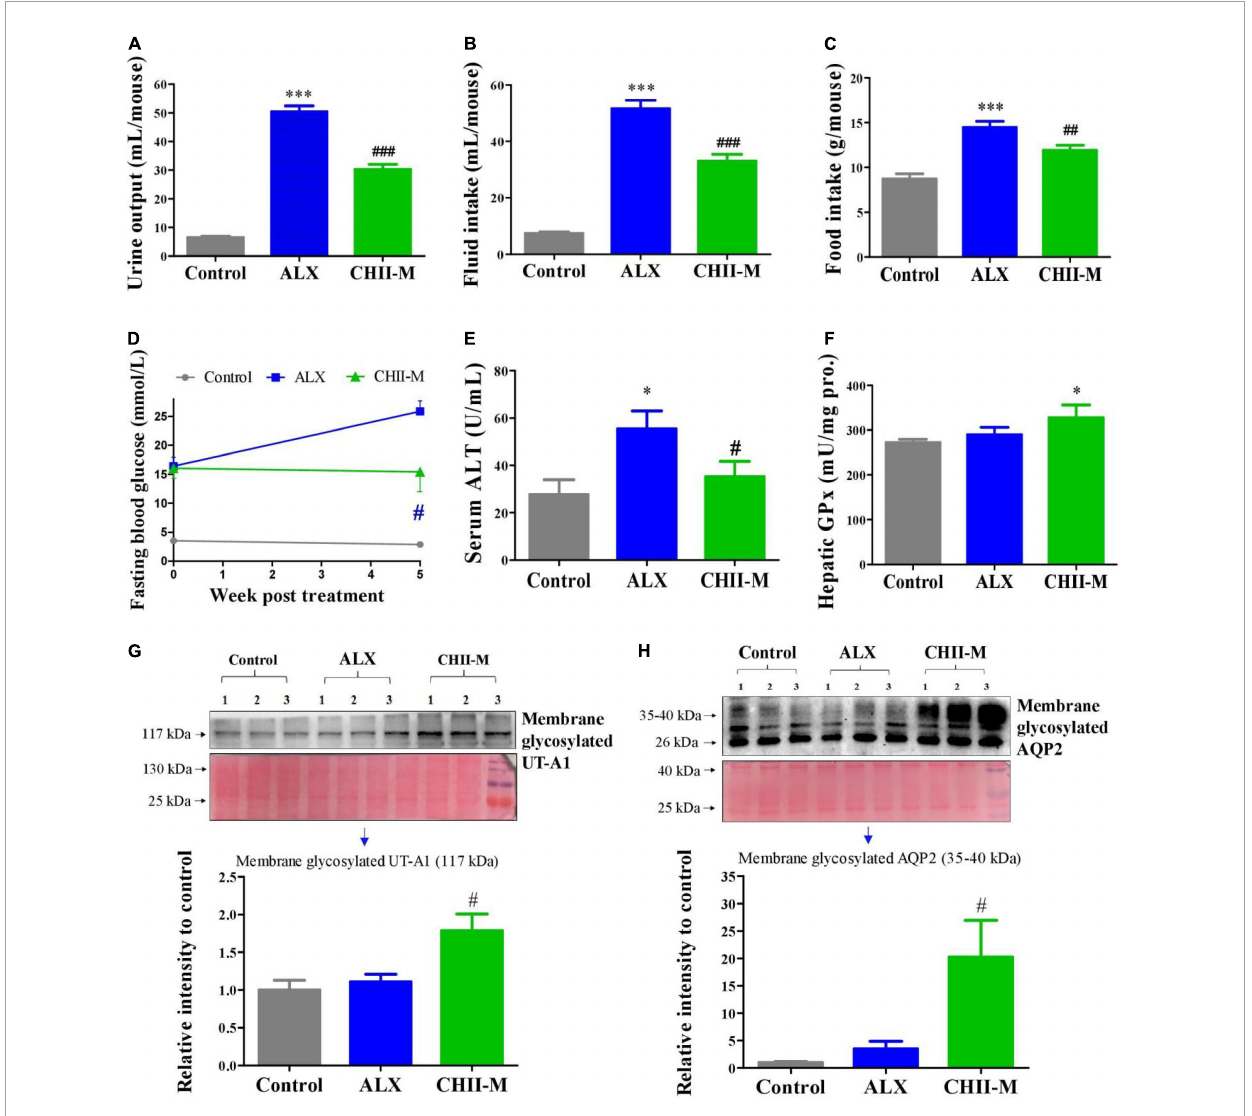
FIGURE3 Effect and mechanism of long-term intake of CHII (1/20, m/v) on symptoms of diabetes in ALX-induced type 1 diabetic mice. Treatments were introduced in animal experiment 3. (A–C) Urine output and fluid and food consumptions. (D) Fasting blood glucose. (E) Level of ALT in serum. (F) Enzyme activity of GPx in liver. (G,H) Protein levels of membrane glycosylated UT-A1 and AQP2 in kidney. ∗ p < 0.05, ∗∗∗ p < 0.001, compared to control. # p < 0.05, ## p < 0.01, ### p < 0.001, compared to ALX. NS, p > 0.05. Data are presented as mean ± SEM ( n = 6).